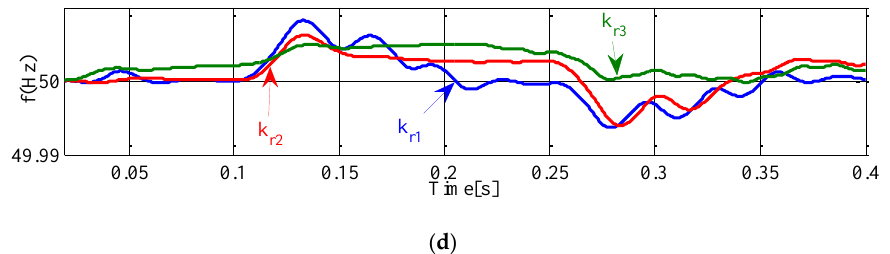
Figure 10. Evaluation of the resonant factor variations: ( a ) active power of the SAPIRC-based converter; ( b ) reactive power of the SAPIRC-based converter; ( c ) the grid voltage magnitude; ( d ) the grid frequency.